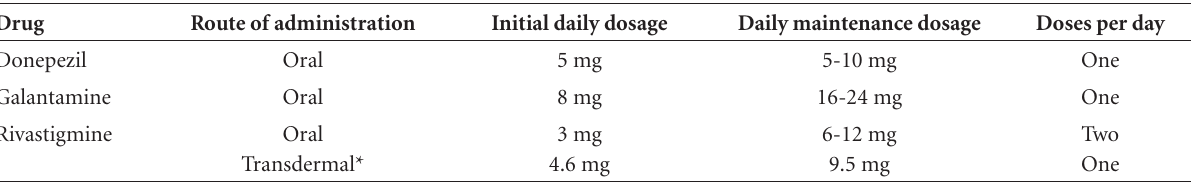
Table 2. Posology of cholinesterase inhibitors.